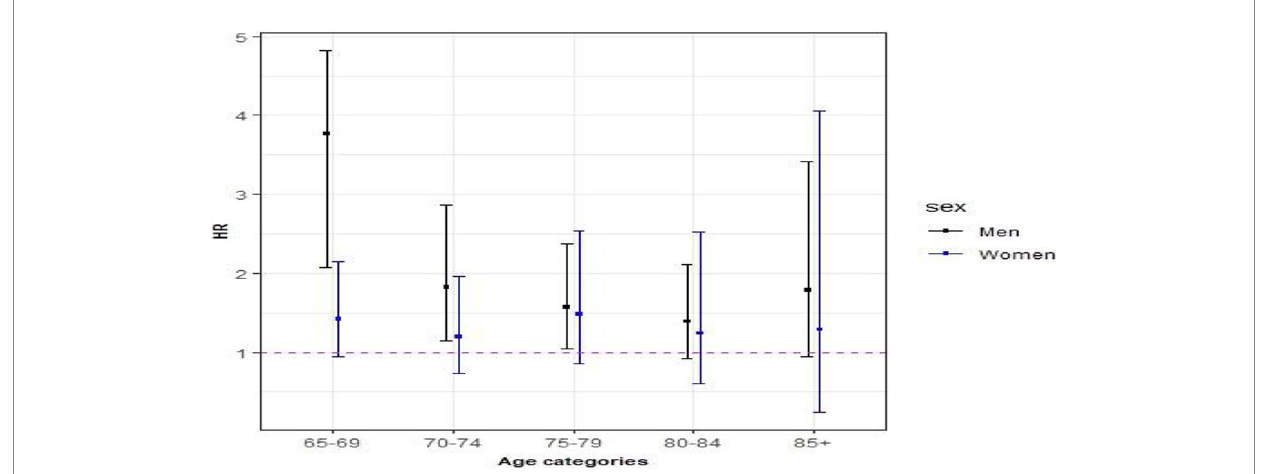
FIGURE 2 Age stratified hazard ratios for the association of multimorbidity with all-cause mortality for men and women. Hazard ratios (95% CIs) for associations of MM with all-cause mortality were calculated for each age group and adjusted for education, family status, smoking habits, alcohol use, BMI, and physical activity.